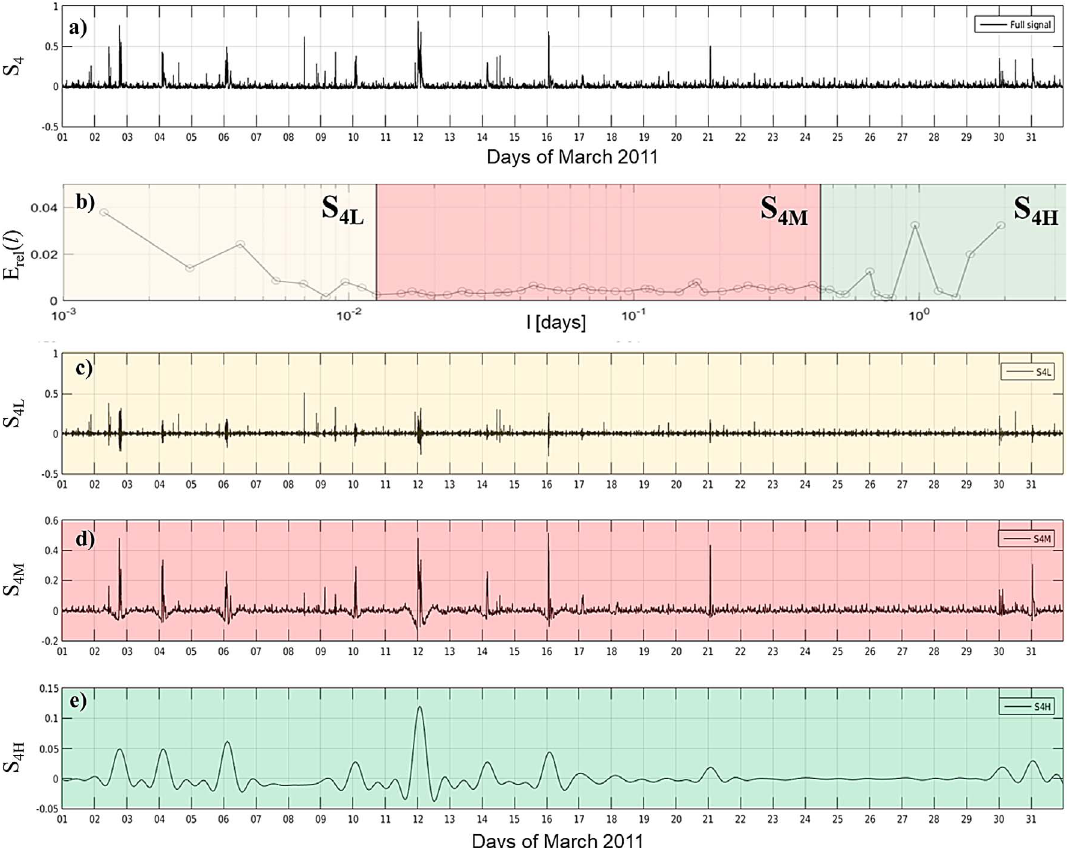
Fig. 3. (a) S 4 time pro fi le over San Miguel de Tucumán during March 2011. (b) Relative energy of each intrinsic mode component of the S 4 index as a function of the period (in days); colors indicate three different intervals of periods: low periods (yellow), middle periods (red) and high periods (green). (c – e) Report the time pro fi les of the sum of the S 4 intrinsic mode components of the low ( S 4L ) , middle ( S 4M ) and high ( S 4H ) periods,